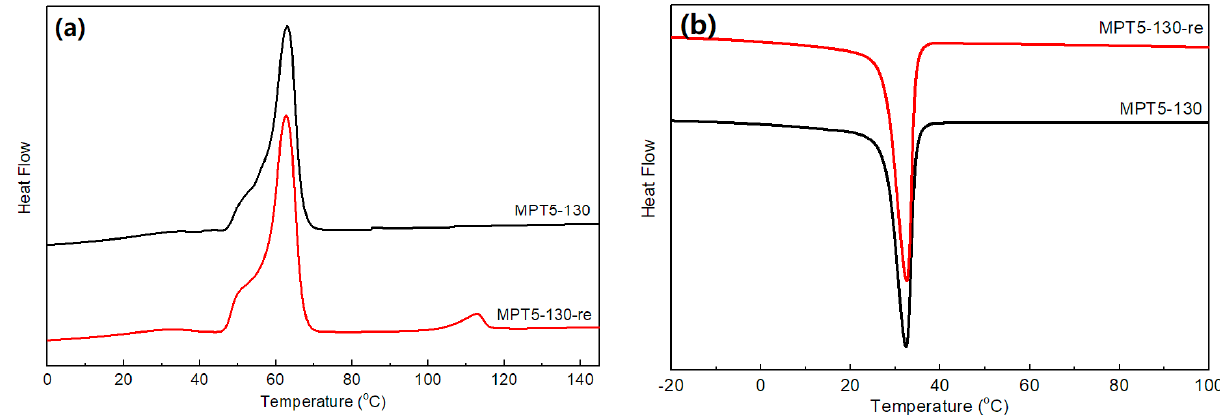
Figure A4. DSC curves of MPT5-130 blends for different heat treatments: ( a ) heating curves; ( b ) cooling curves. Table A1. Thermal properties of PCL/MPT blends with different processing temperatures. Specimen